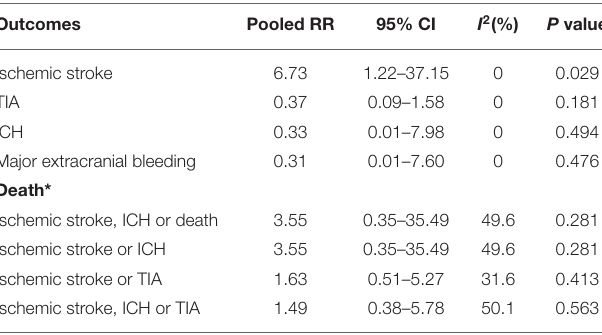
TABLE 3 | The outcomes of comparison between the antiplatelet and anticoagulation therapies in intention-to-treat (ITT)